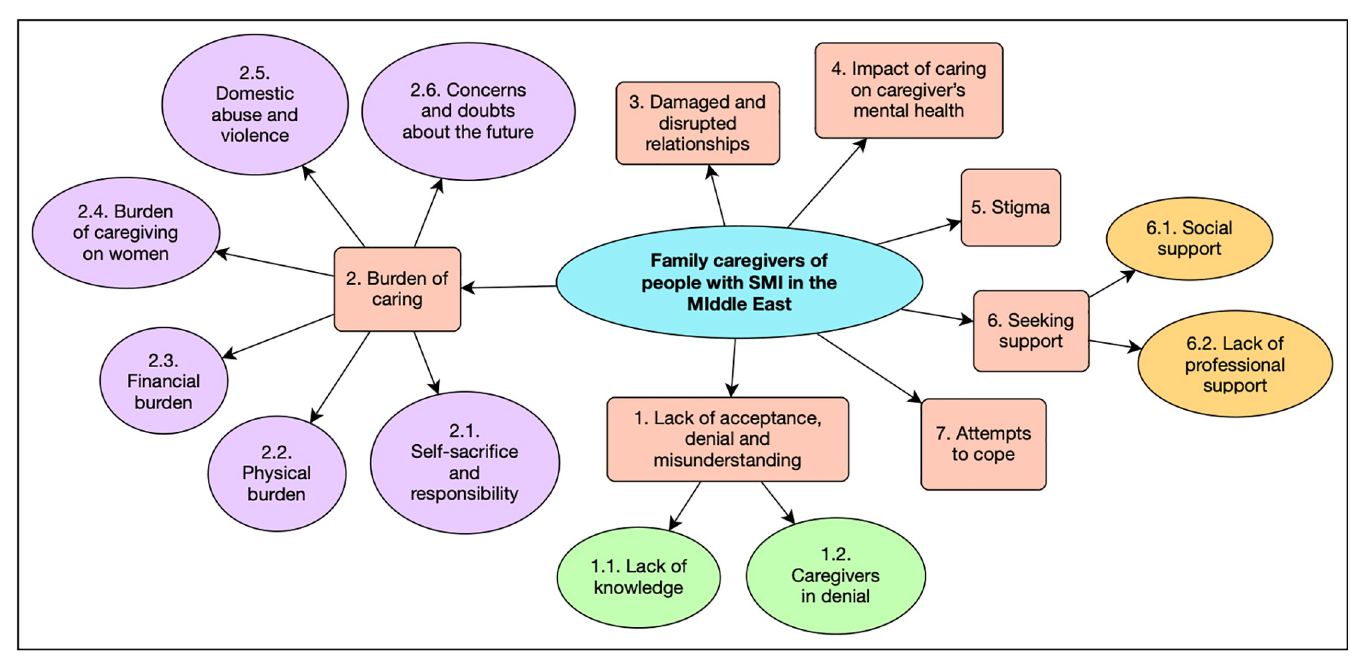
Fig 2. Overarching